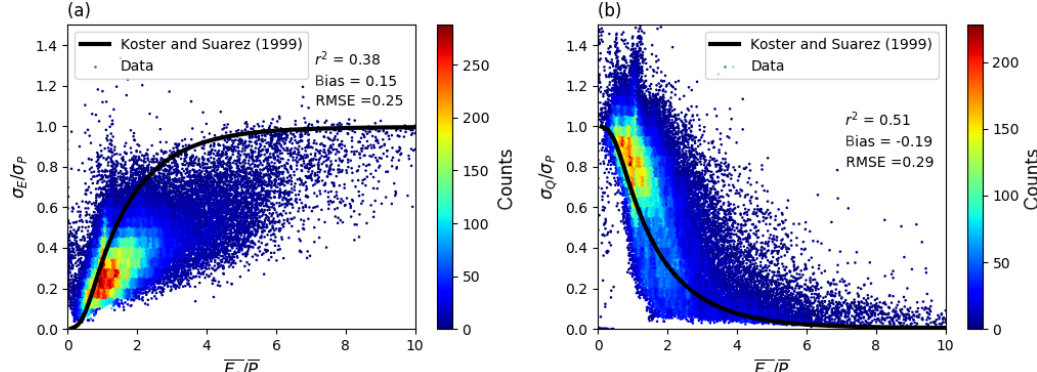
Figure 5. Relationship of inter-annual standard deviation of (a) evapotranspiration ( σ E /σ P ) and (b) runoff ( σ Q /σ P ) ratios to aridity ( E o /P ). The curves represent the semi-empirical relations from Koster and Suarez (1999).